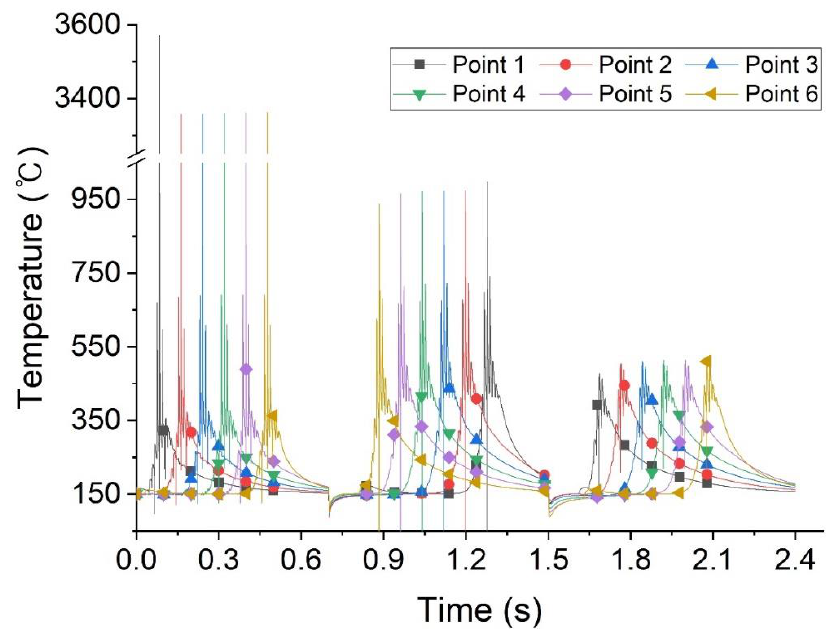
Figure 5. Results of temperature changes in the first layer (6 points shown in Figure 2).